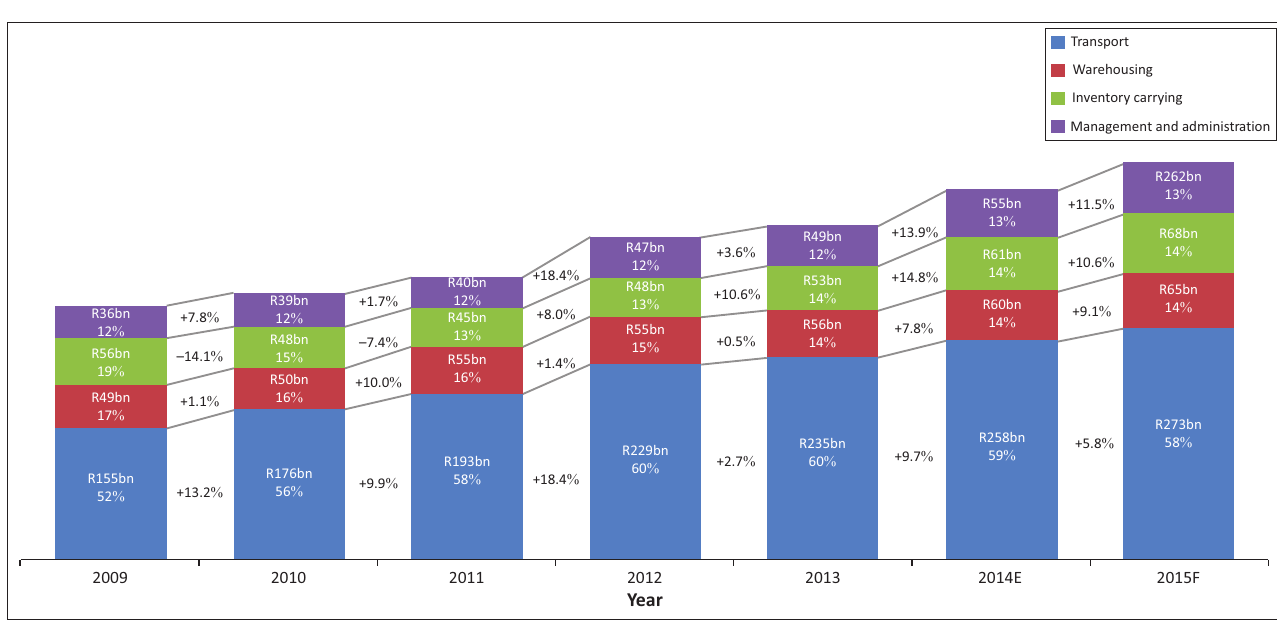
FIGURE 3: South Africa’s logistics costs as percentage of total and transportable gross domestic product.